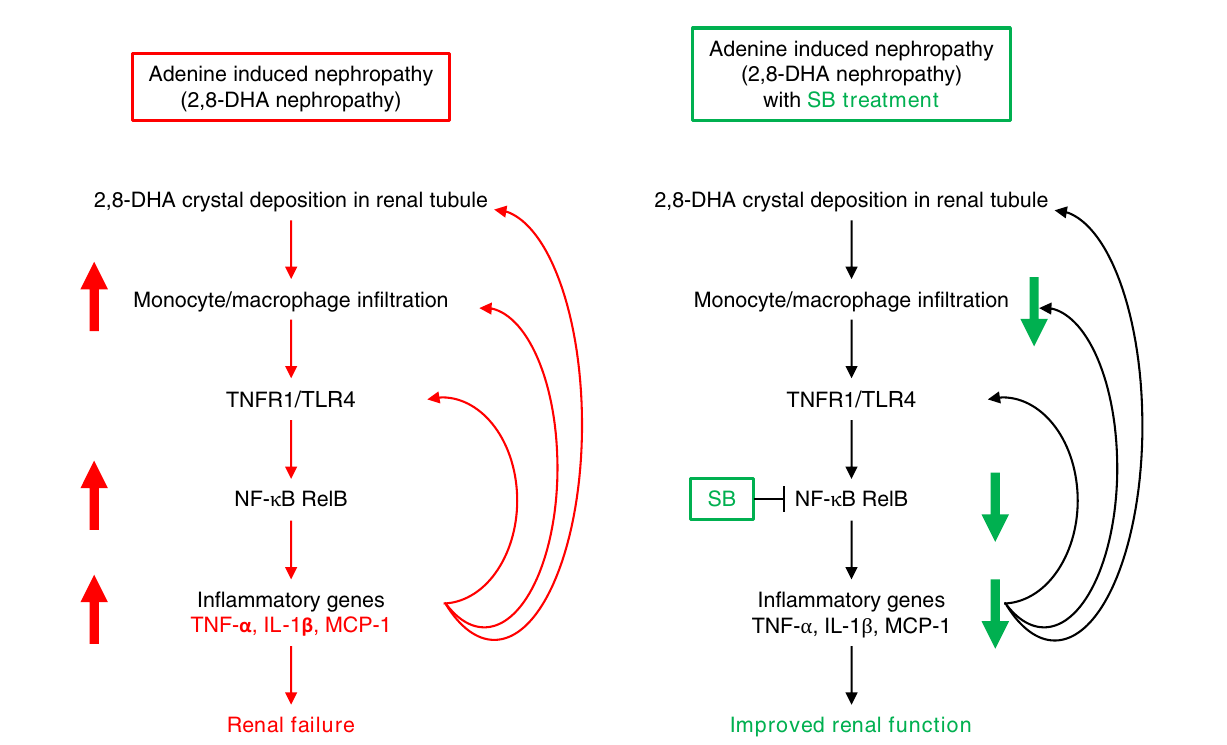
Figure 8. Graphical abstract showing the beneficial effects of SB in the kidneys of AdCKD mice. Left panel: In AdCKD mice, 2,8-DHA crystal deposits accumulated in renal tubules leads to monocyte/macrophage infiltration into the kidney tissue following upregulated expression of inflammatory genes such as TNF-α, IL-1β, and MCP-1, as well as TNFR1 and TLR4. In this process, NF-κB RelB is also increased. The upregulated inflammatory genes positively regulate additional crystal deposition 7 , monocyte/macrophage infiltration, and the expression of inflammatory genes. This positive feedback loop resulted in renal failure. Right Panel: SB treatment reduces the expression of NF-κB RelB and inflammatory genes, thereby down regulating monocyte/ macrophage infiltration and the expression of the inflammatory genes, improving renal function. AdCKD, adenine induced chronic kidney disease; SB, sodium benzoate; CKD, chronic kidney disease; TNFR1, tumor necrosis factor receptor 1; TNF-α, tumor necrosis factor α; IL-1β, Interleukin 1 beta; MCP-1, Monocyte chemoattractant protein-1; TLR4, Toll-like receptor